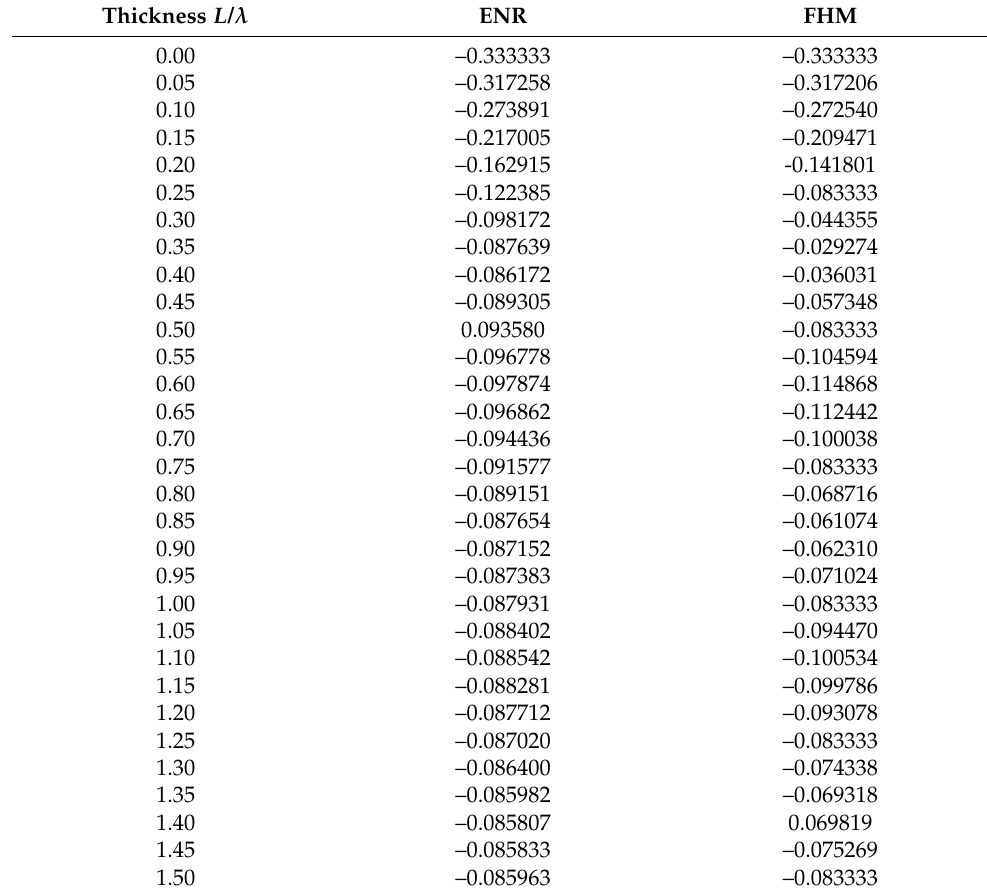
Table 1. ENR frequency shifts vs. FHM [1]